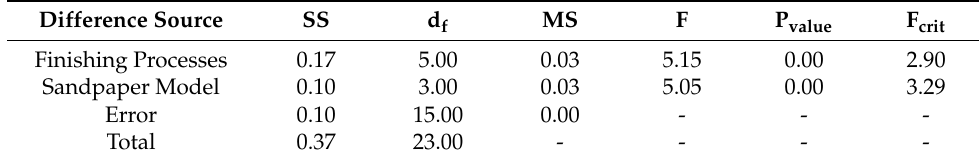
Table 16. Significance analysis of